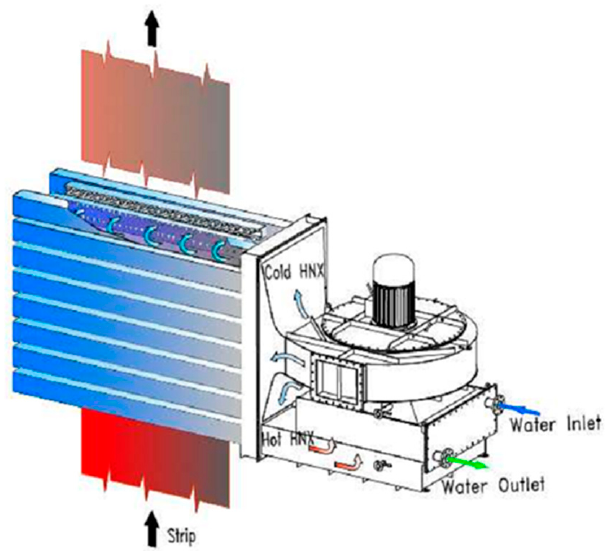
Figure 11. Schematic of the jet cooler system. Table 2. Main geometrical data of the industrial cooling module.